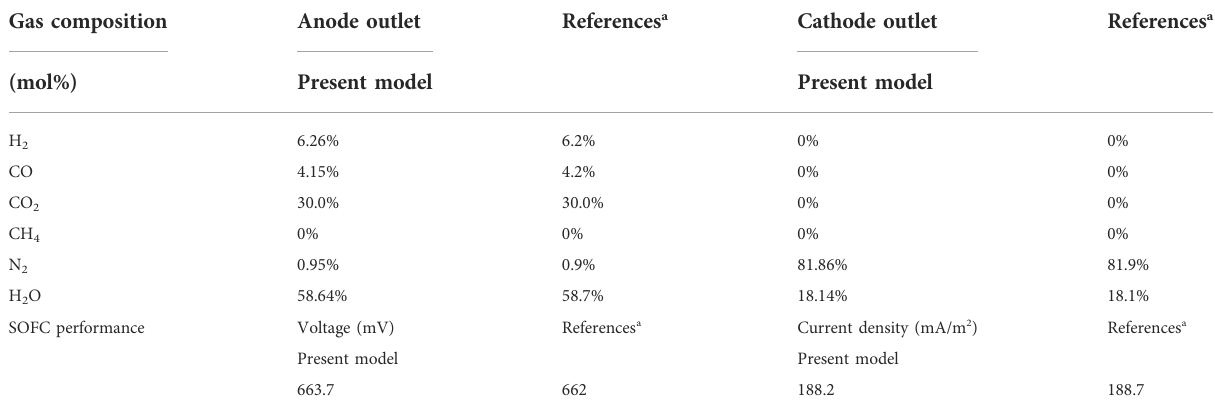
TABLE 5 A comparison of simulation results for SOFC